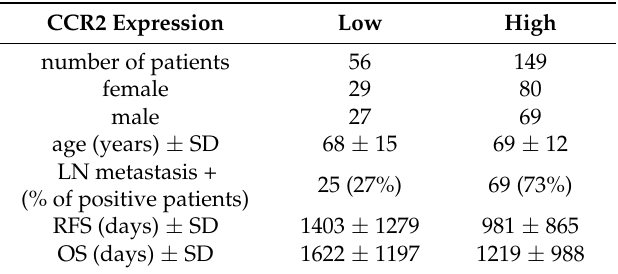
Figure 5. CCR2 expression in cells and colon cancer patients: ( A ) CCL7 receptor expression assessed using real time PCR, ( B ) low CCR2 expression in colon cancer patients, ( C ) high CCR2 expression on TMA, and ( D ) Kaplan–Meier plot of overall survival (OS) for patients stratified according to CCR2 expression assessed as low or high. Table 4. Characteristics of colorectal cancer patients stratified according to low and high grading of CCR2 expression.